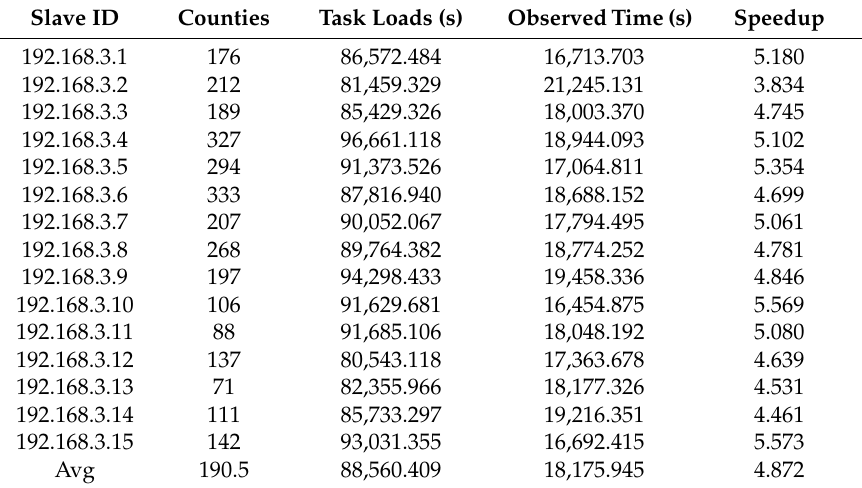
Table 7. Performance improvement in a cluster (All the CPU cores were